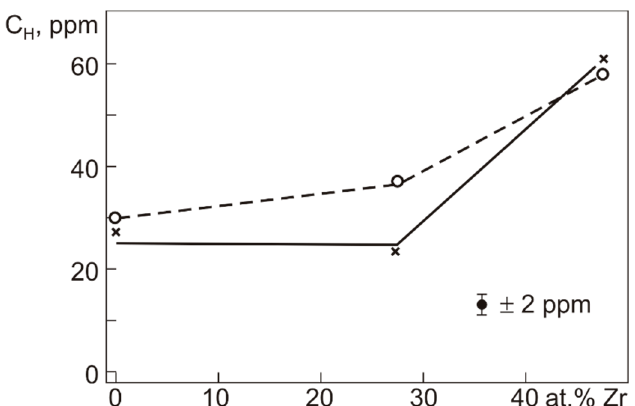
Figure 11. Average hydrogen concentration in the coated Ti0.16Pd alloy specimens immediately after hydrogenation versus the content of Zr in the coating (Table 2). Substrate: Ti0.16Pd with microcrystalline (o) and SMC (×) structure.